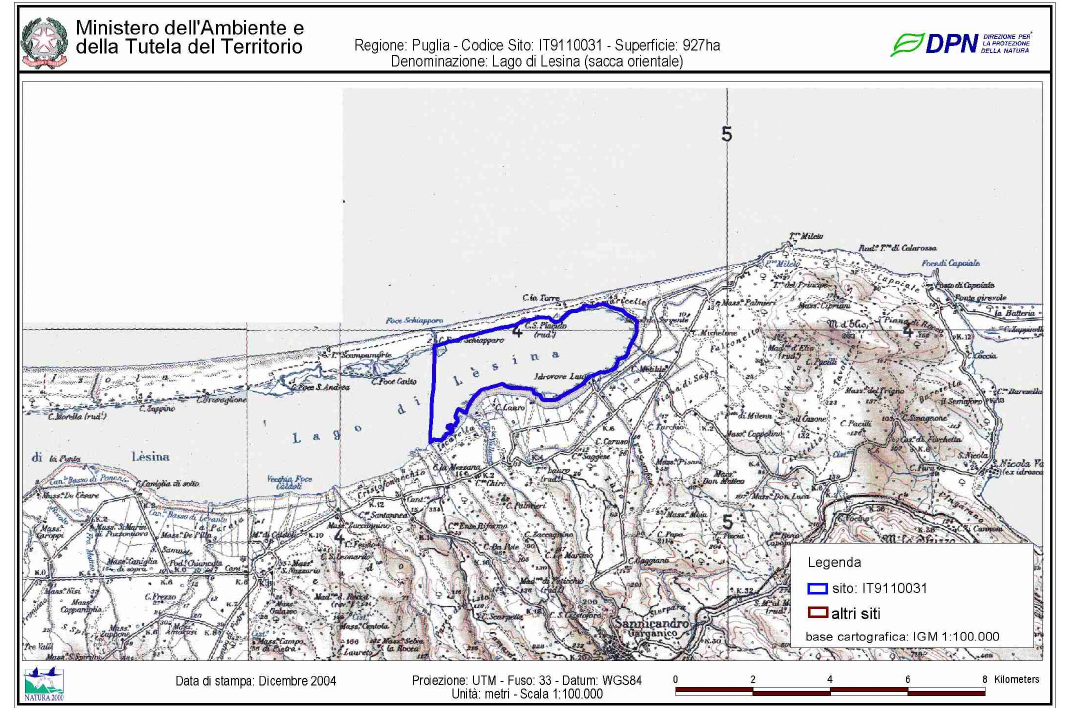
Figure 7. Part of Lesina Lagoon which is a bird sanctuary included into the Gargano National Park (Courtesy: Directorate for Nature Protection). (Courtesy: Directorate for Nature